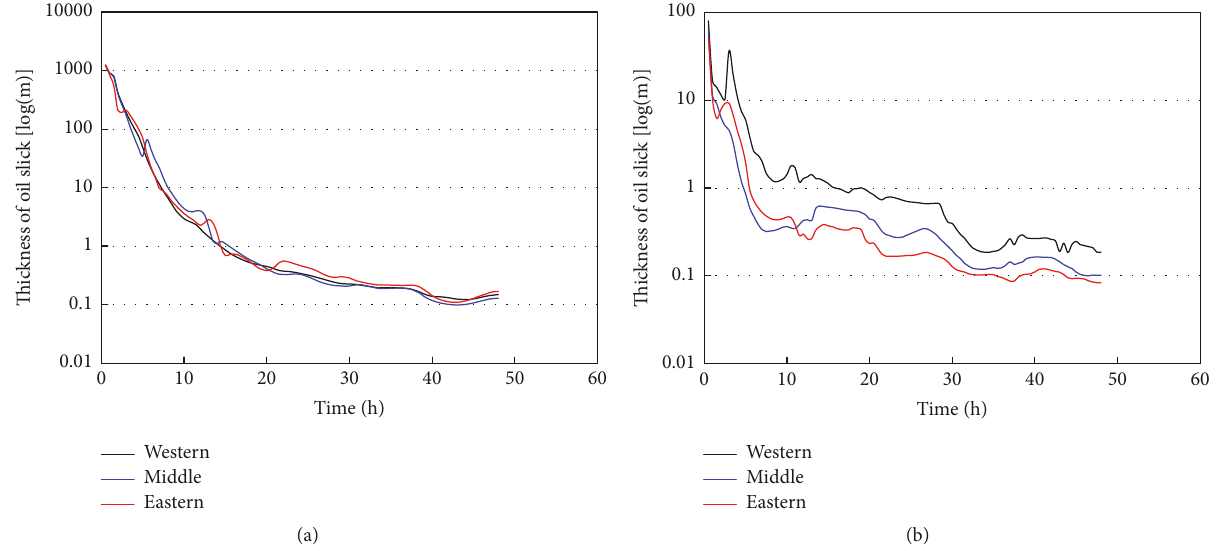
Figure 25: Slick thickness of instantaneous (a) and continuous (b) oil spills versus time in different spill locations (black line for the western spill location, blue line for the middle spill location, and red line for the eastern spill location) in the case of no wind.